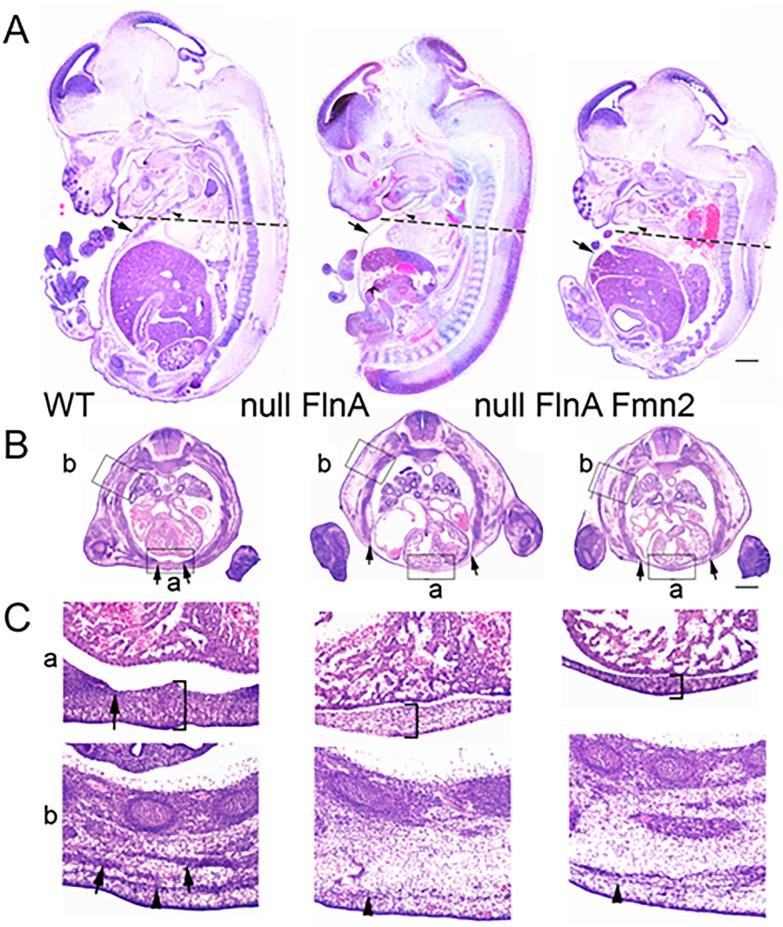
Loss of FlnA and Fmn2 leads to smaller body size, thinned muscle, and skeletal wall, as well as defects in cardiac valves.A. Brightfield photomicrographs of sagittal sections of E13.5 mouse embryos stained with hematoxylin and eosin (H&E) demonstrate the smaller body size and thinned or unformed ventral body wall (arrows) in the null FlnA and null FlnA+Fmn2 embryos. B. H&E staining of transverse whole body sections corresponding to the dashed lines in (A) shows severe developmental defects in the muscle/ribs along the lateral thoracic and ventral body wall. C. Higher magnification photomicrographs corresponding to boxed area (a) in panel B capture the thinned ventral body wall (bracket) in the double knockout mice. In the age-matched WT mice, the ventral wall is considerably thicker and the rib/sternum (arrow) has migrated near the midline. Higher magnification photomicrographs corresponding to the boxed area (b) in panel B display a severe defect in thoracic muscle formation in null FlnA, and null FlnA+Fmn2 embryos (arrows marked muscles). Scale bar = 500 μm.